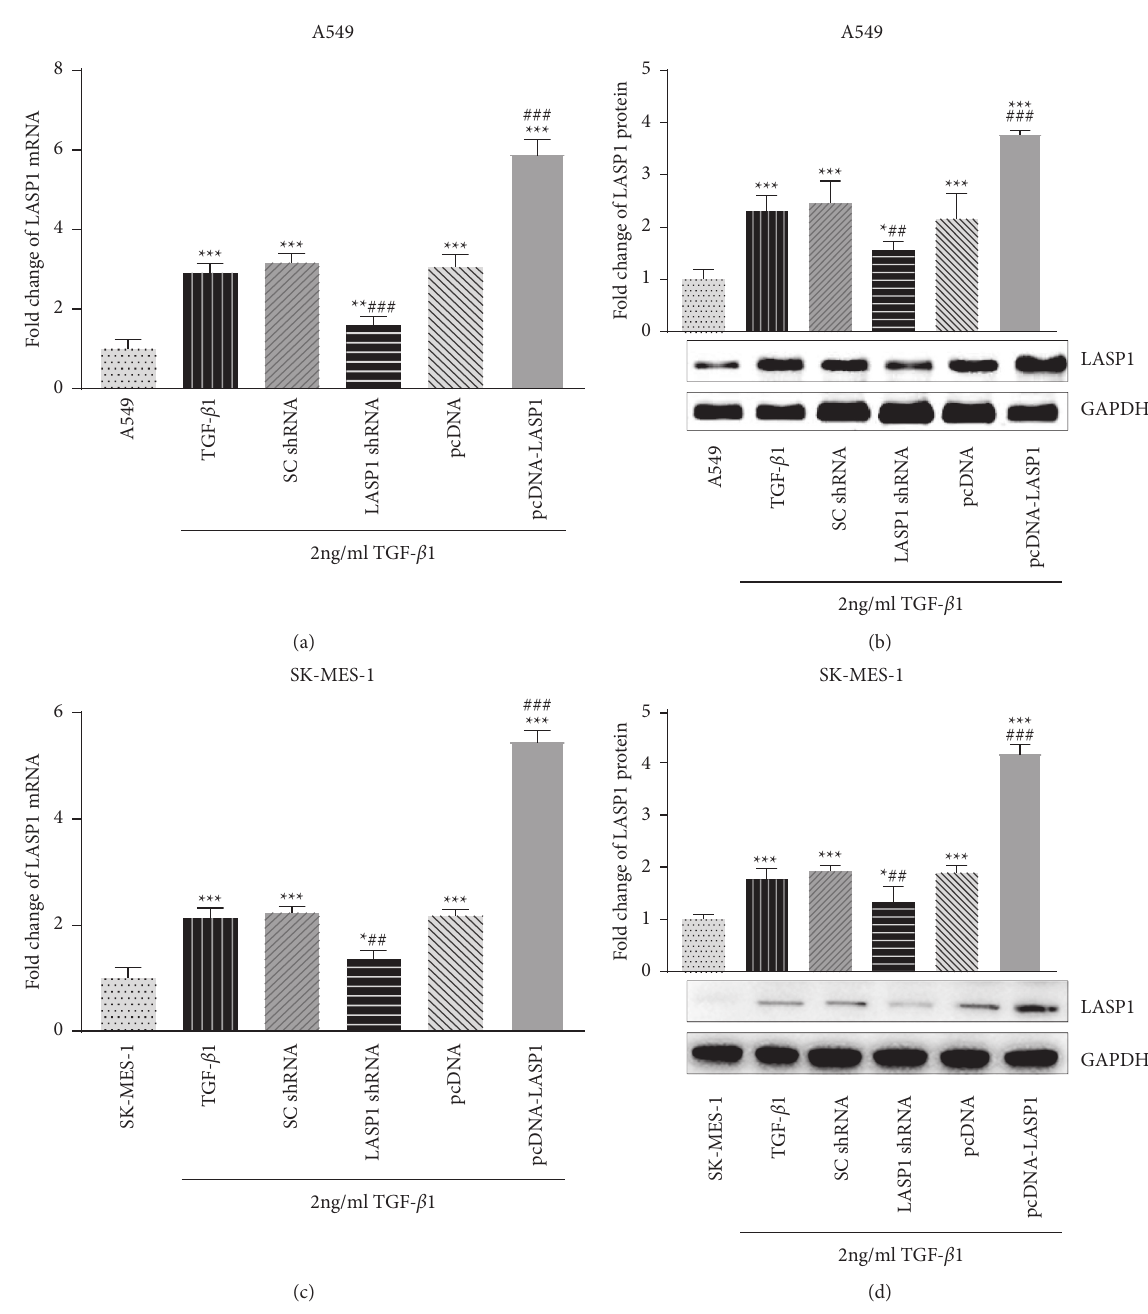
Figure 2: (a–d) LASP1 knockdown and overexpression efficiency in TGF- β 1-treated A549 and SK-MES-1 cells. After coinfection with 2ng/ ml TGF- β 1 and lentivirus containing LASP1 shRNA or 2ng/ml TGF- β 1 and pcDNA-LASP1, the cells were lysated to detect mRNA and protein levels of LASP1. Fold change mRNA expression levels of LASP1 were quantified by RT-qPCR in A549 (a) and SK-MES-1 (c) cells. Western blot confirmed the change of LASP1 protein levels in A549 (b) and SK-MES-1 (d) cells. All quantitative amounts were normalized against GAPDH expression and shown as mean ± SD, n � 6. ∗ p < 0 . 05 and ∗∗∗ p < 0 . 001 vs. the cell alone group without TGF- β 1 treatment, and # p < 0 . 05, ## p < 0 . 01, and ### p < 0 . 01 vs. the TGF- β 1-treated noninfection